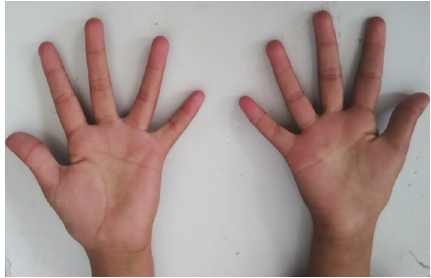
Figure 2: Showing atrophy of right thenar muscle.